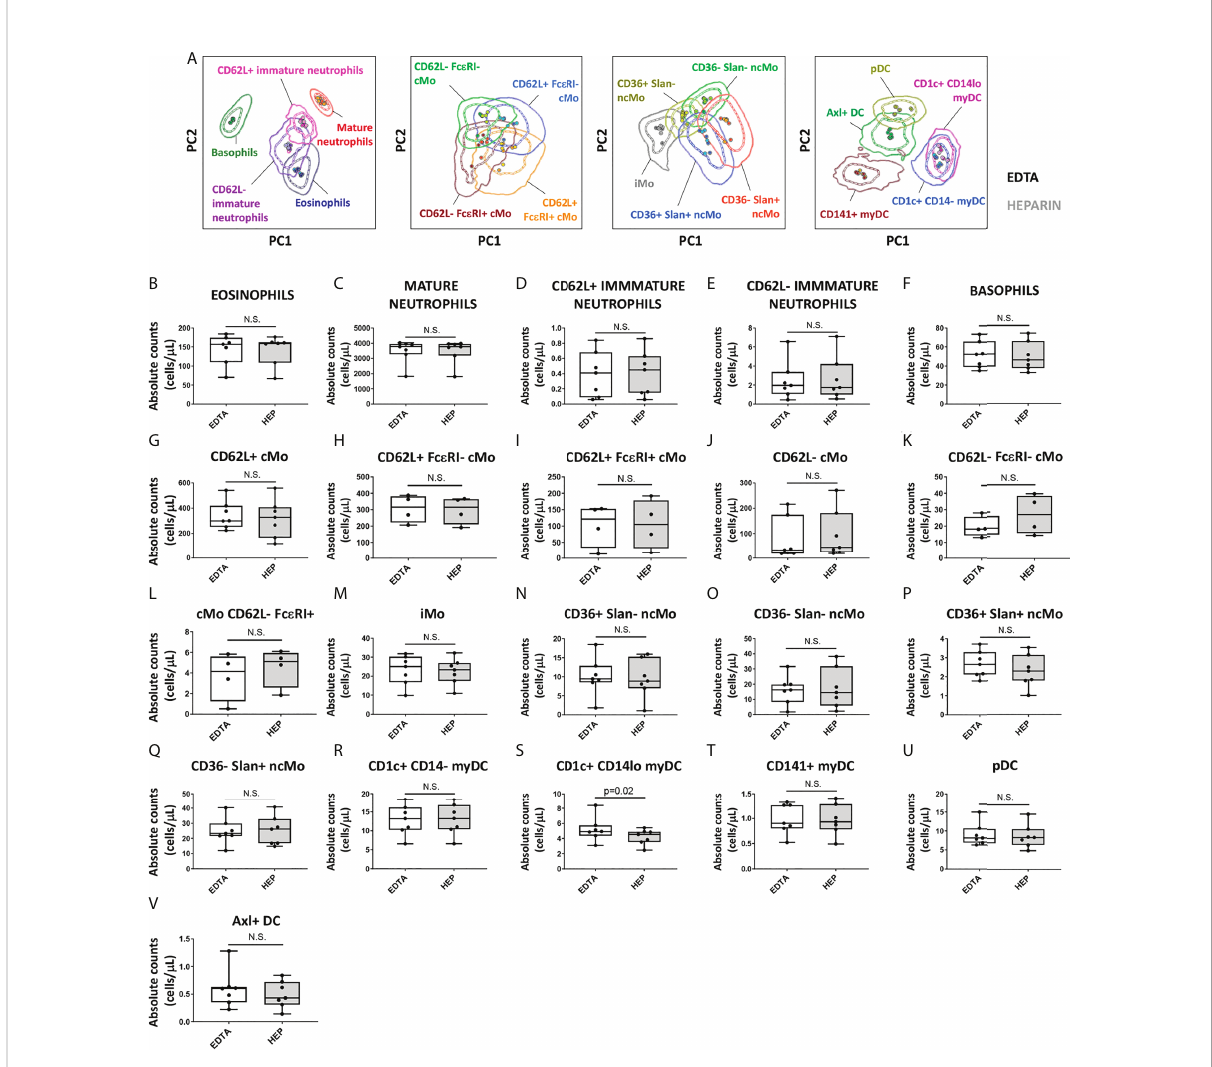
FIGURE 6 Impact of the anticoagulant on the staining patterns and IMC population (absolute) counts in blood. Peripheral blood samples (n=7) were collected into K3 ethylenediaminetetraacetic acid (EDTA) and sodium heparin (HEP) tubes and stained with versions 2 (n=3) and 3 (n=4) of the EuroFlow immunemonitoring innate myeloid tube. (A) depicts principal component analysis (PCA) plots comparing the staining patterns for the populations identi fi ed in samples collected in EDTA vs. HEP (version 3; n=4). (B-V) show the impact of the anticoagulant used for sample collection on the absolute counts of the different IMC populations identi fi ed using the EuroFlow innate myeloid cell tube. Statistical differences were evaluated empoying the Wilcoxon test. Solid circles in all PCA plots represent median values for the parameters evaluated in each sample, inner dotted and outer solid lines depict the fi rst standard and second standard deviations for each population identi fi ed in the EDTA-anticoagulated samples. cMo, classical monocytes; iMo, intermediate monocytes; ncMo, non-classical monocytes; pDC, plasmacytoid dendritic cells; myDC, myeloid dendritic cells; PC, principal component; EDTA, ethylenediaminetetraacetic acid; HEP, sodium heparin. N.S., not statistically signi fi cant (p